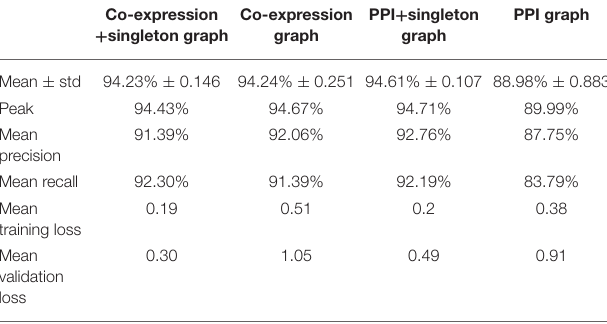
TABLE 2 | Performance of predicting cancer types of four GCNN models trained by combined tumor and normal samples. Co-expression Co-expression PPI + singleton + singleton graph graph